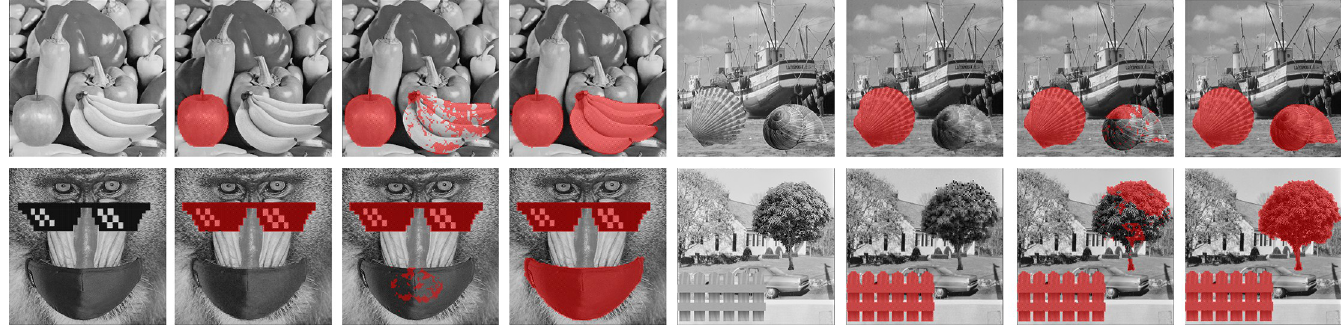
Fig 14. Detection results of [18], [16], [17] and the proposed method for complex images. (a)-(d) Peppers image. (e)-(h) Boat image. (i)-(l) Baboon image. (m)-(p) House